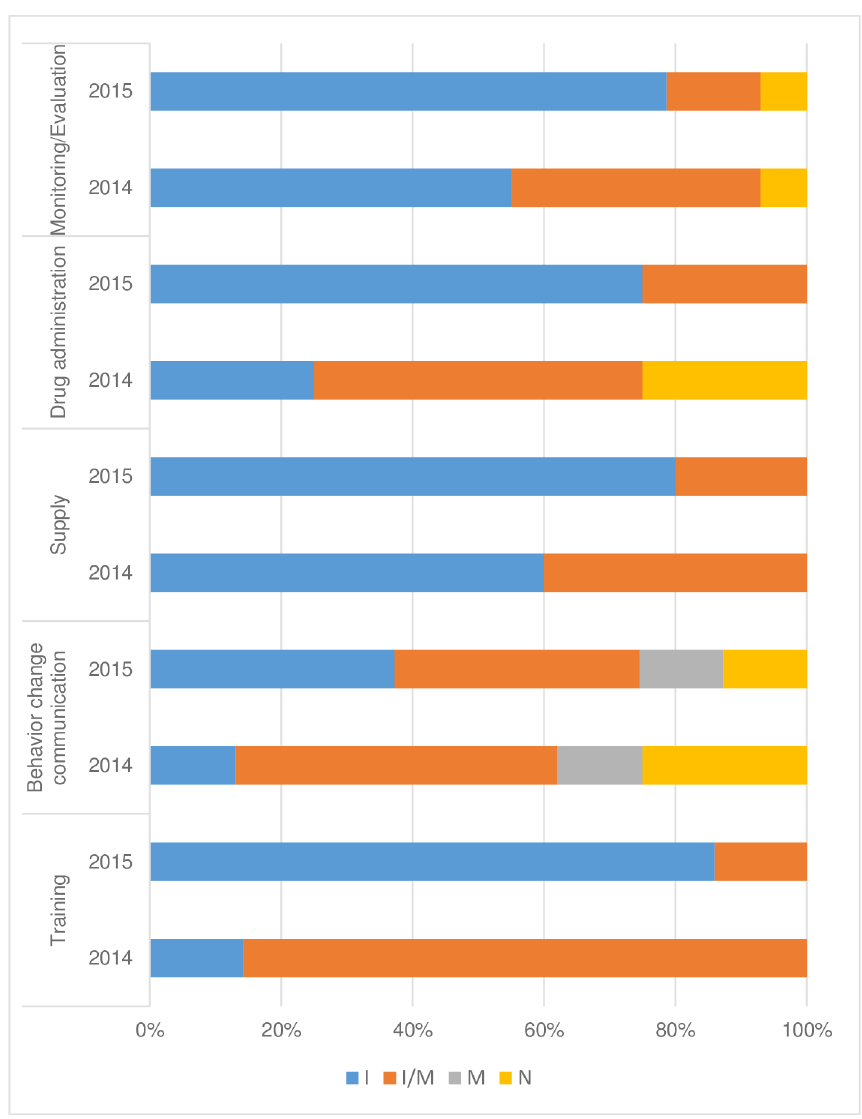
Fig 2. Content fidelity of the SMC components in 2014 and 2015. Notes: I = implemented as intended;I/ M = implemented or modified;M = modified;N = not